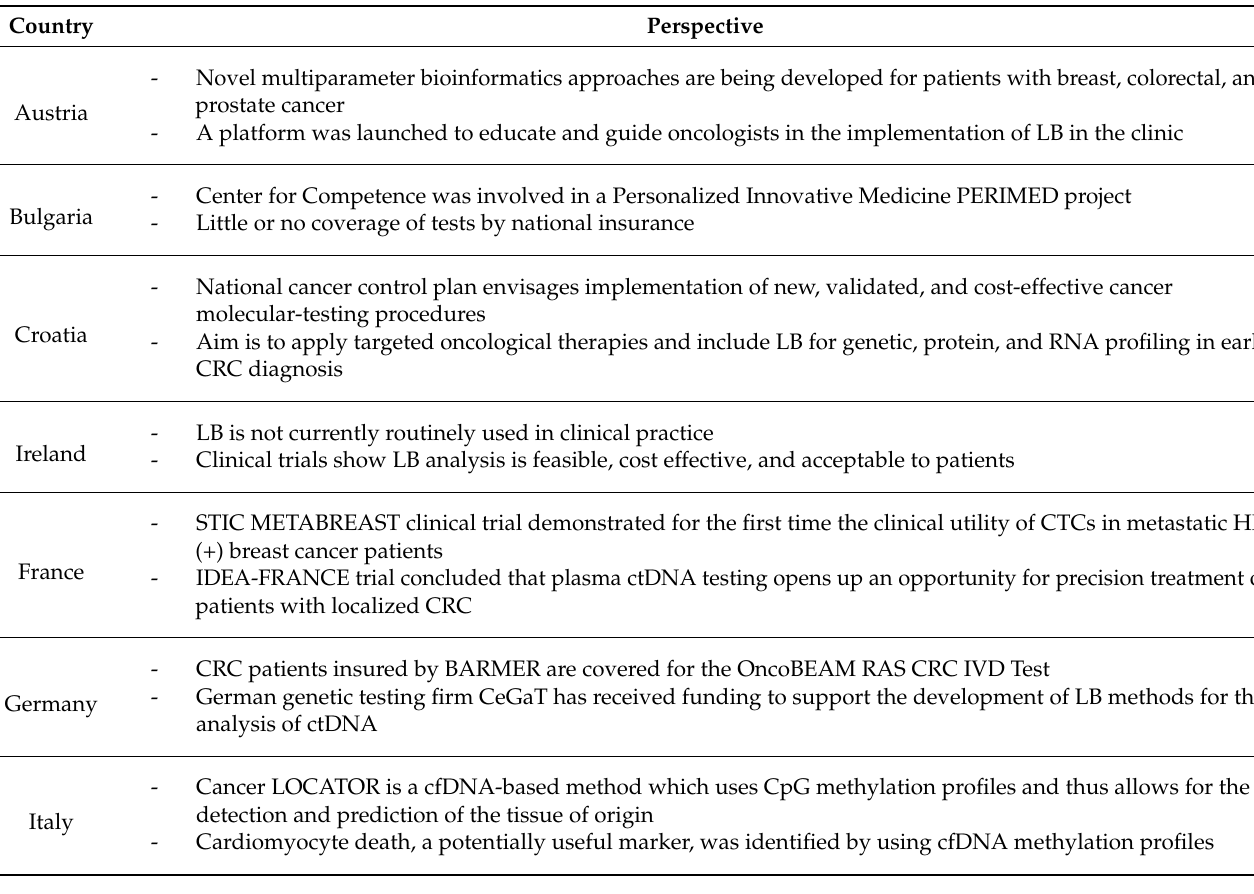
Table 1. Different perspectives and challenges among European countries with implementation of LB in the healthcare system. Country